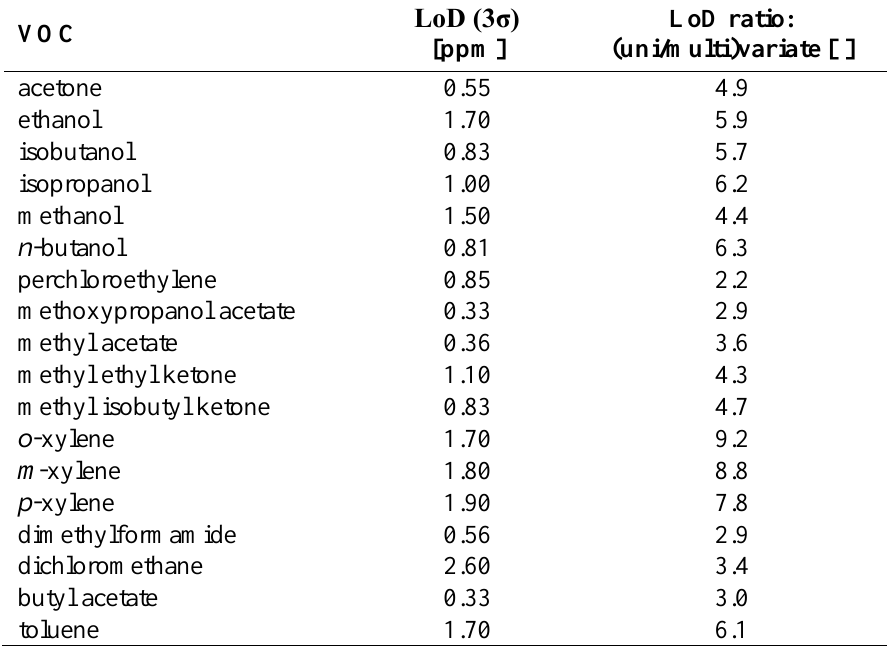
Table 4. LoD for each measured VOC as 3σ. For both the noise and the analyte signal, the full spectral area from 500 to 4,500 cm −1 was used. The concentration of each VOC was 100 ppm. The LoD ratio relates the uni- with the multivariate LoD and is an indicator of how much better the multivariate LoD